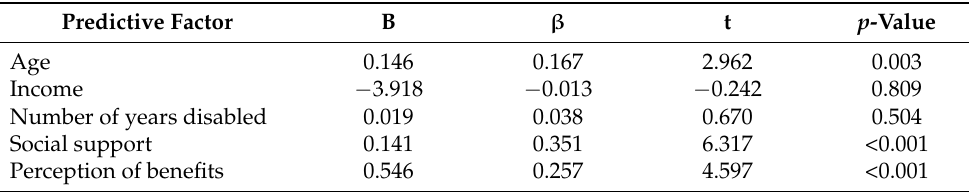
Table 2. Factors associated with access to health services.